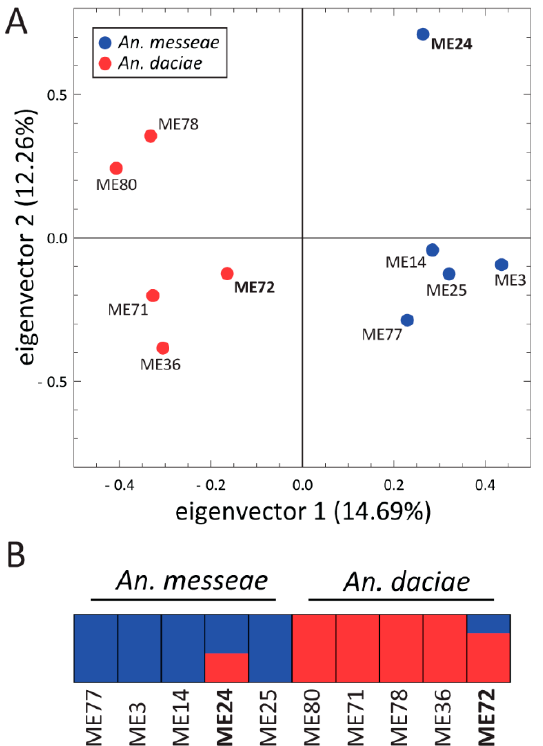
centromeric regions. T and C stands for telomeres and centromeres, respectively. Genes 2020 , 11 , x FOR PEER REVIEW